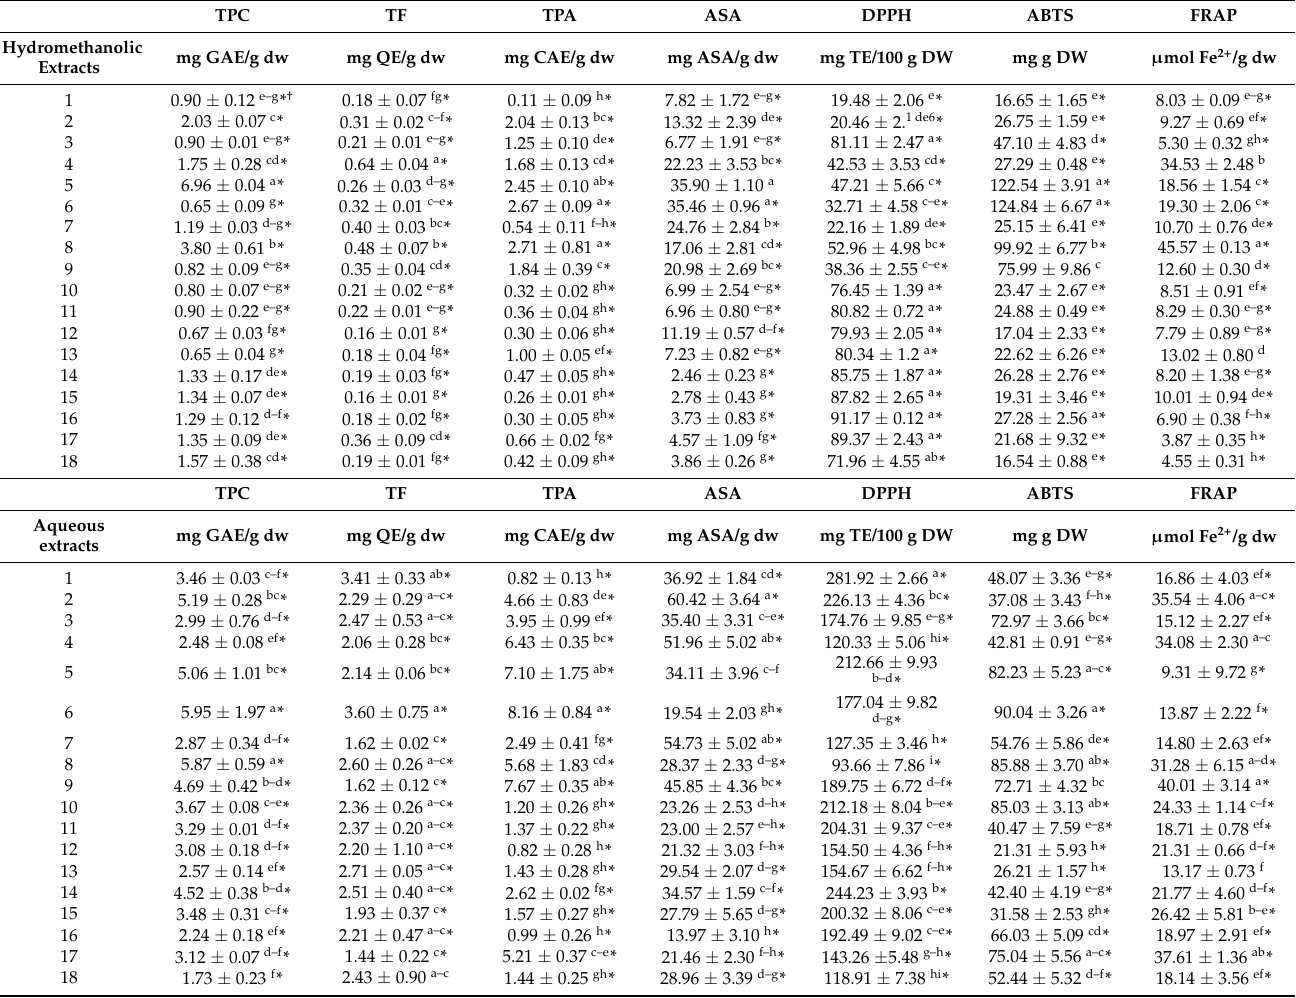
Table 3. Total phenolic compounds (TPC), flavonoids (TF), phenolic acids (TPA), L(+) ascorbic acid (ASA) contents, and DPPH, ABTS, and FRAP assays in the tested hydromethanolic and aqueous extracts of W. somnifera samples (mean ±